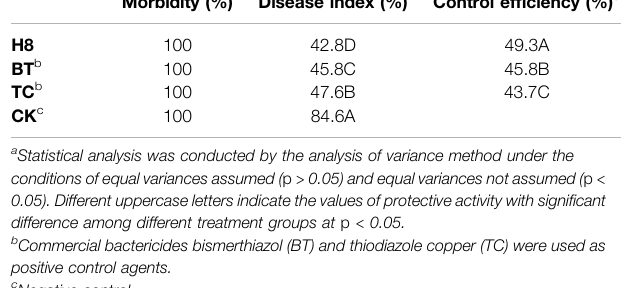
Frontiers in Chemistry |